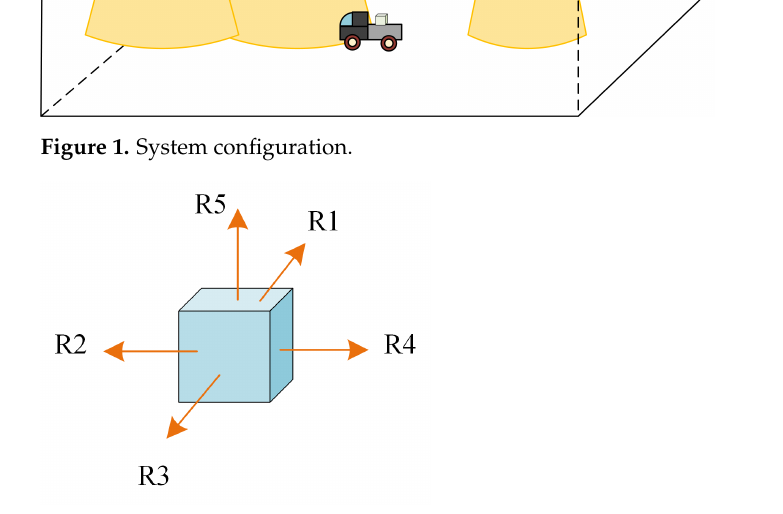
Figure 2. The structure of